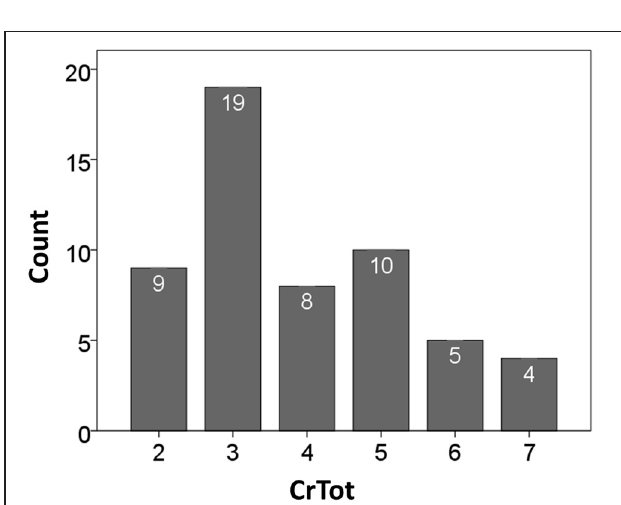
FIGURE 2 | Distribution of cough epochs according to CrTot.